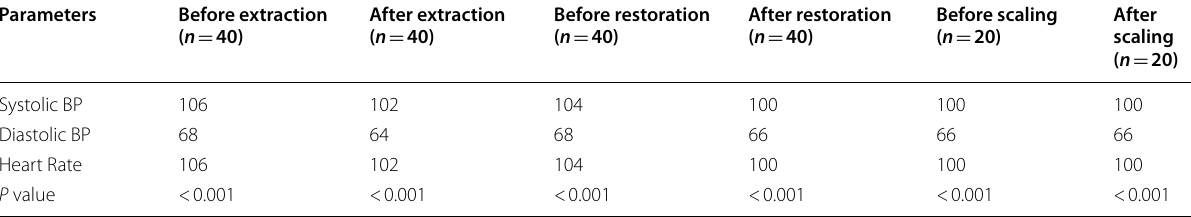
Table 6 Comparative evaluation of parameters of children before and after treatment procedures Parameters